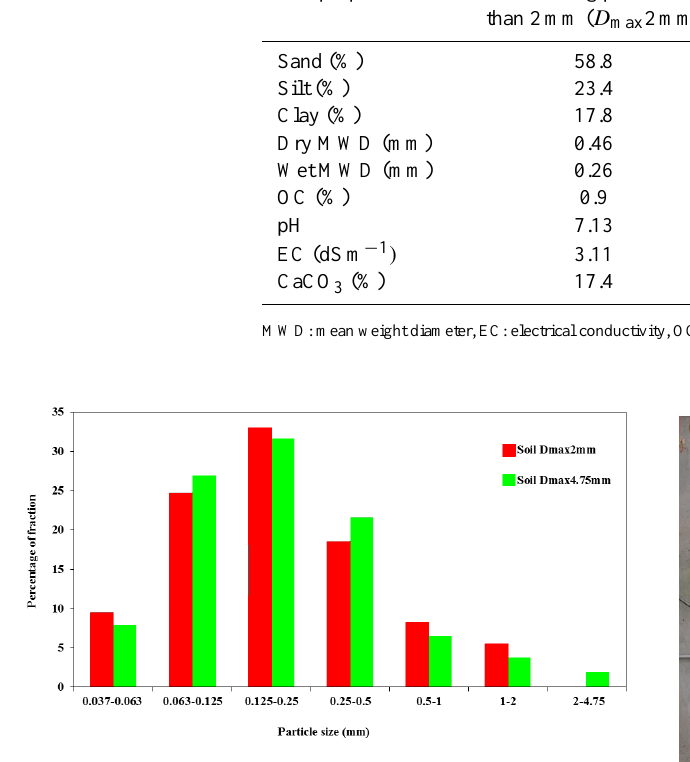
Table 1. Some physical and chemical properties of the soils used in the experiments. Soil properties